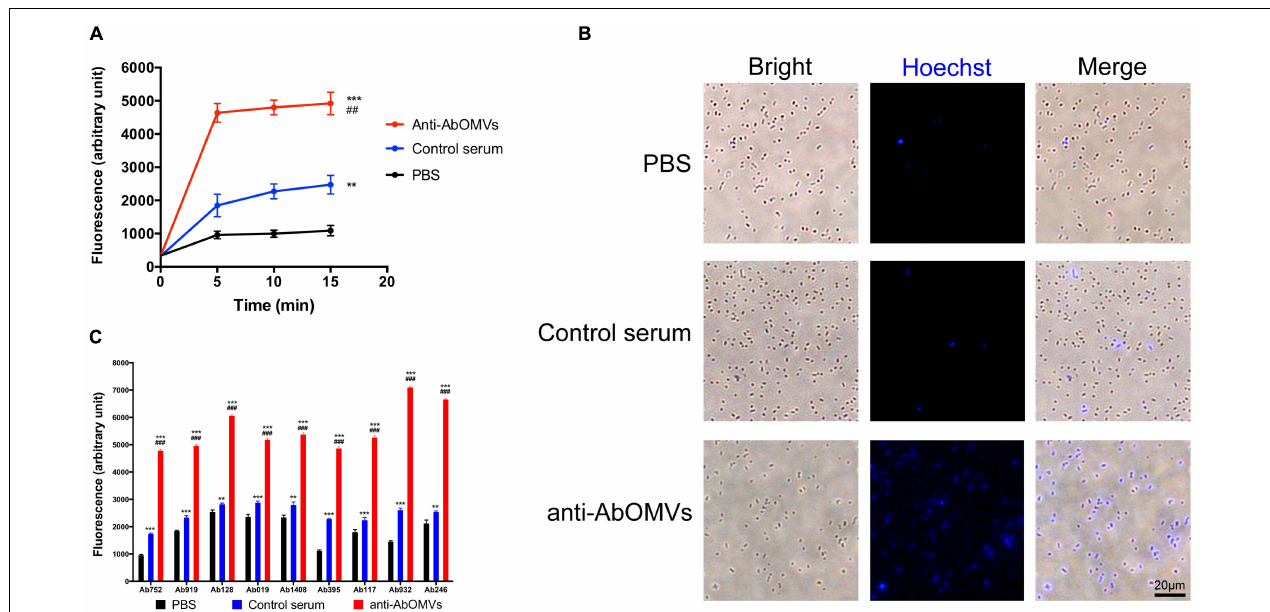
FIGURE 2 | Anti-AbOMV serum significantly increased the aggregation of small molecules in cells. (A) The antibodies were incubated with the Ab112 strain for 30 min; then, HT was quickly added, and the dynamic uptake efficiency of HT by the strain was tested every 5 min. The experiment was repeated four times. ∗ Indicates comparison with the PBS group; # indicates comparison with the control serum group. (B) After the Ab112 strain was incubated with HT for 15 min, intracellular staining of the bacteria was observed by fluorescence microscopy; the size of each image is the same, bar: 20 µ m. (C) Fluorescence uptake data were measured 15 min after 9 PDR A. baumannii strains were mixed with HT. The experiment was repeated four times. ∗∗∗ / ### P < 0.001; ∗∗ / ## P < 0.01.